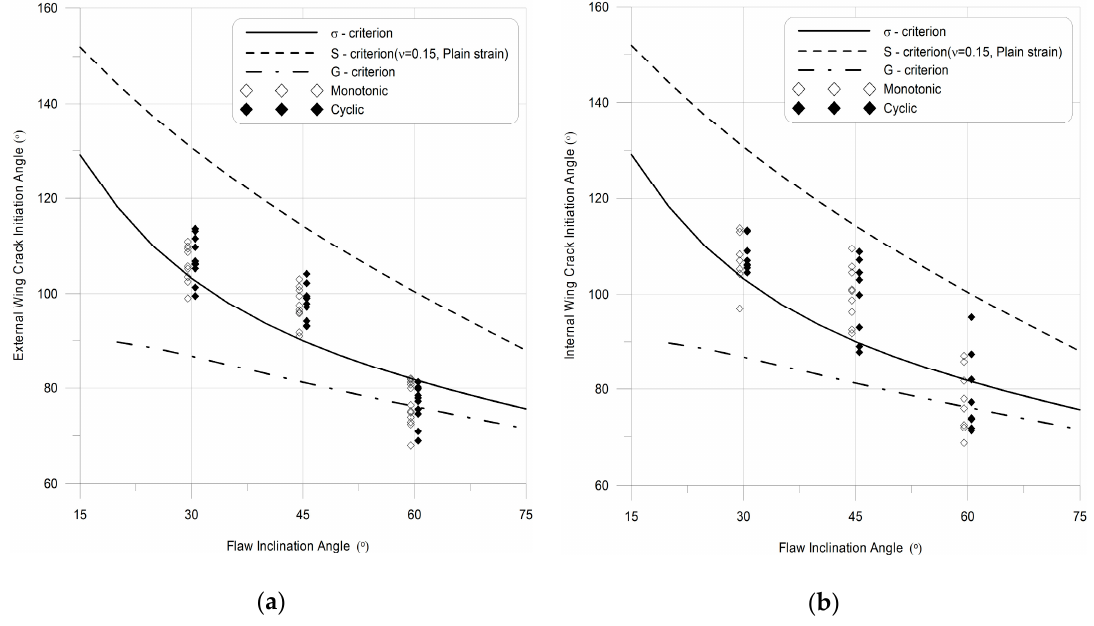
Figure 15. Comparison of wing crack initiation angle: ( a ) external wing crack; ( b ) internal wing crack.